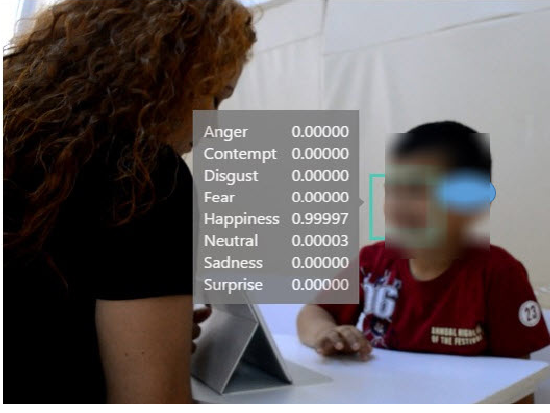
Figure 2. Student 1’s emotional analy- sis